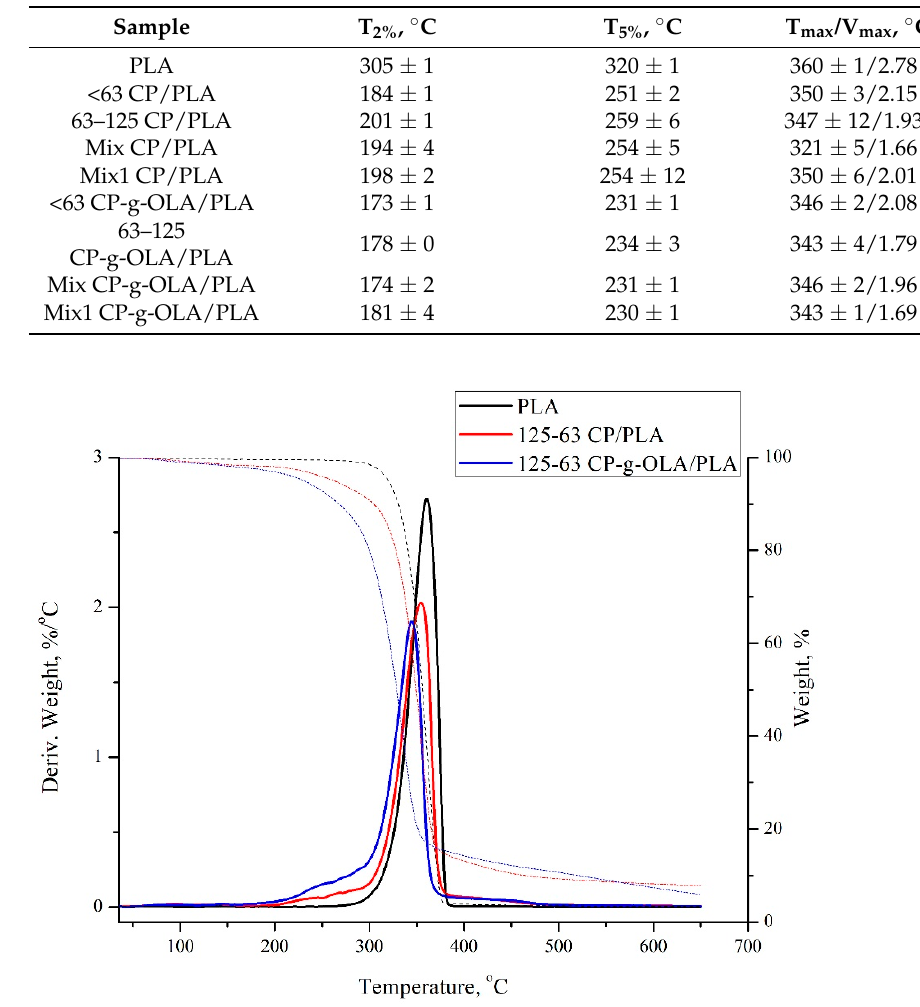
Figure 7. TG and DTG curves of PLA and biocomposites.